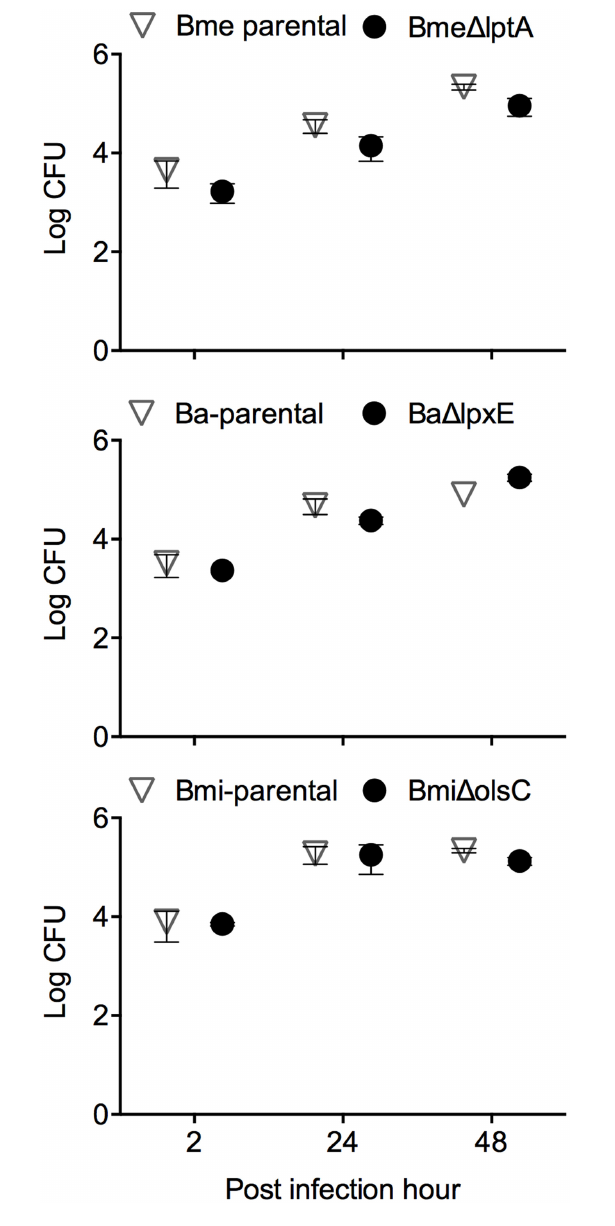
FIGURE 4 | LptA, LpxE, and OlsC deletions do not alter the Brucella interaction with dendritic cells. Intracellular replication in BMDCs (each point represents the mean ± standard error of the logarithm of CFU in dendritic